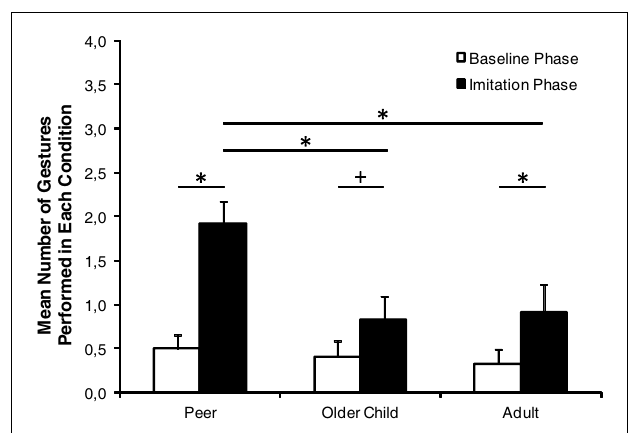
FIGURE 1 |The mean percentage of gestures the infant performed in each experimental condition. Asterisks indicate significant differences ( p < 0.05). Crosses indicate a tendential significant difference ( p <